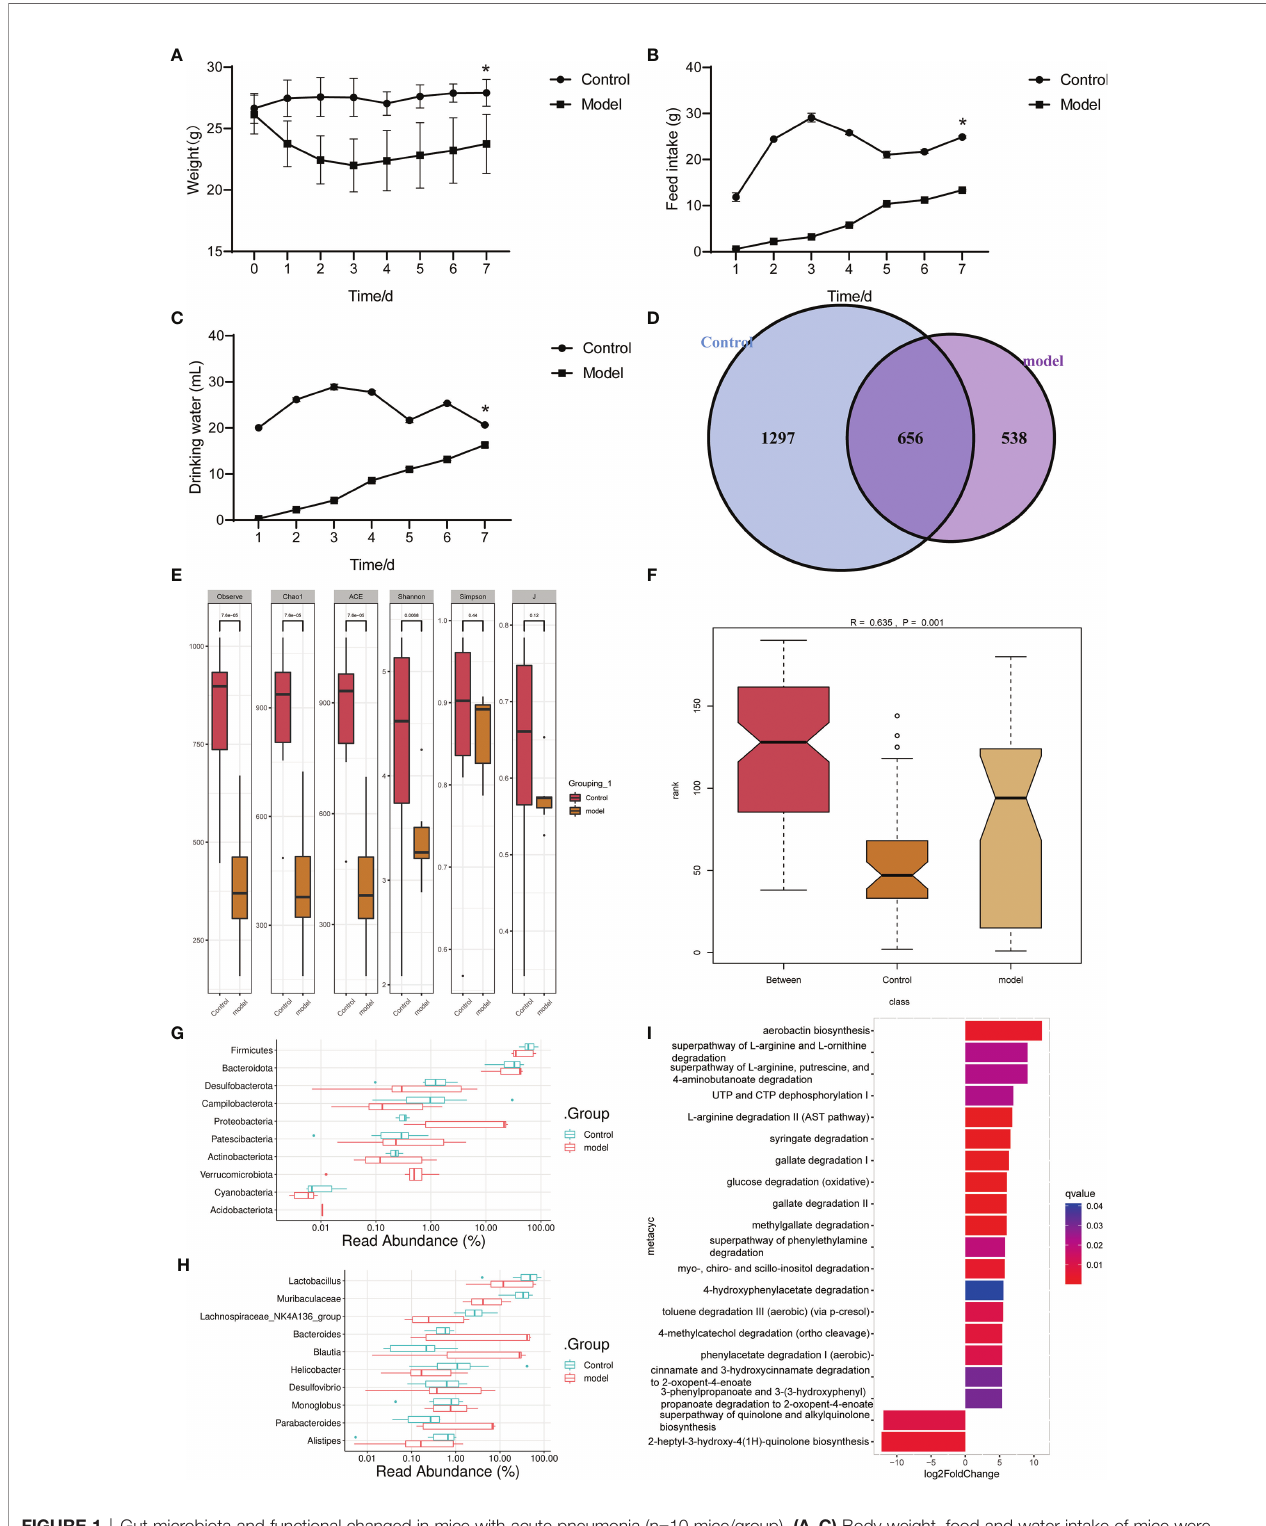
FIGURE 1 | Gut microbiota and functional changed in mice with acute pneumonia (n=10 mice/group). (A – C) Body weight, food and water intake of mice were observed and monitored for 7 days. (D) Venn diagram showed changes in microbial population. (E) Alpha diversity index. (F) Beta diversity index. (G, H) The histogram showed microbiota abundance at the phylum and genus level. (I) The annotation of microbiota functional pathway. N=5 sample/group for 16S rRNA sequencing. * P < 0.05 vs Control